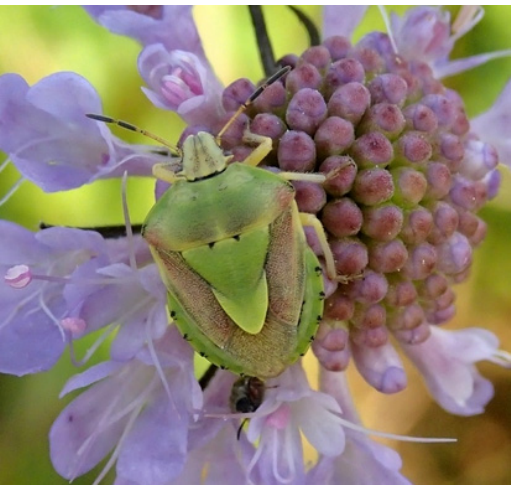
Figure 7. Antheminia lunulata (Goeze 1778) (photo P.